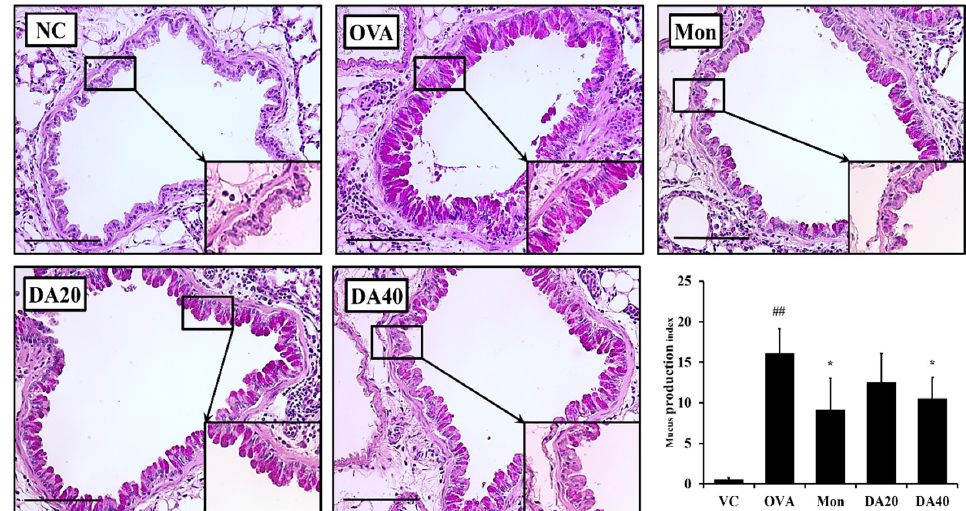
Figure 8. DA reduced mucus production in the lung tissue of OVA-induced asthma model. Lung tissue was stained with PAS solution. NC: normal controls, PBS treatment and inhalation; OVA: PBS treatment with OVA sensitization and inhalation; Mon: montelukast-treated mice (10 mg / kg, oral gavage) with OVA sensitization and inhalation; DA20 and 40: Dipsacus asperoides C. Y. Cheng et T. M. Ai-treated mice (20 and 40 mg / kg, respectively, oral gavage) with OVA sensitization and inhalation. Scale bar = 50 µ m. The values shown as the mean ± SD. ## p < 0.01 vs. NC; * p < 0.05.